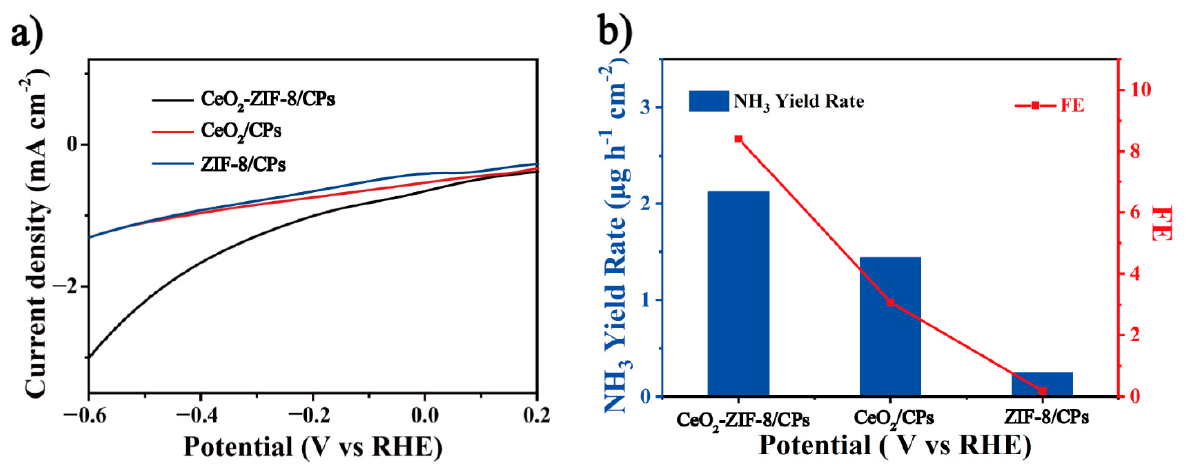
Figure 4. ( a ) The NRR electrochemical performances of CeO 2 -ZIF-8/CPs, CeO 2 /CPs and ZIF-8/CPs in 0.5 M K 2 SO 4 of nitrogen saturated at a scan rate of 2 mV/s; and ( b ) Faradaic efficiency (red) and